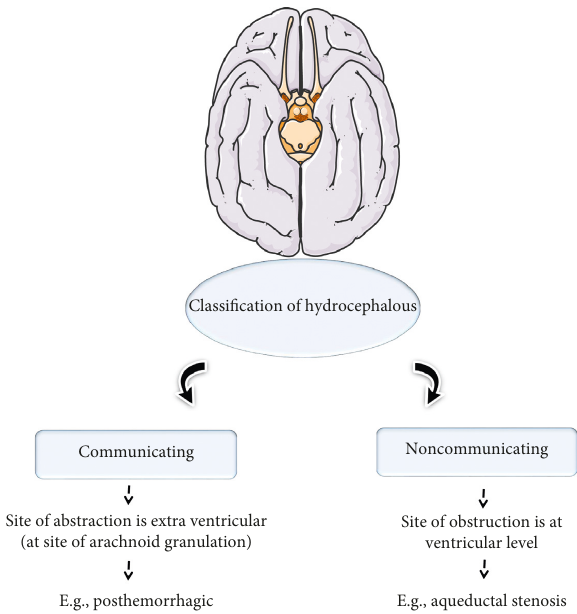
Figure 3: Classification of hydrocephalus. Examples of two types, communicating and noncommunicating, are